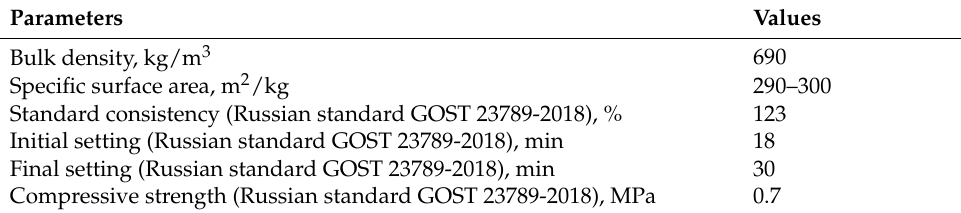
Table 4. Characteristics of the